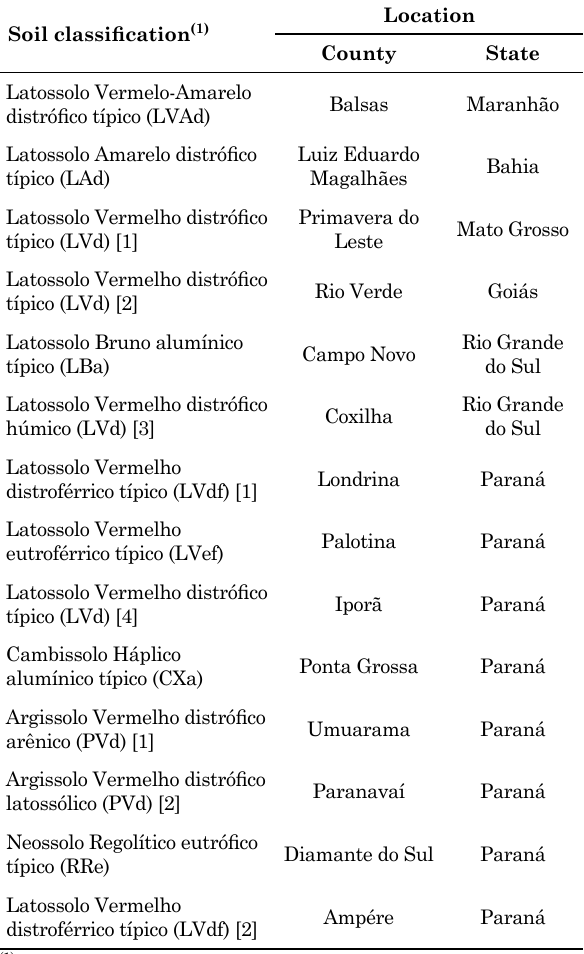
Table 1. Classification and location of soil samples from the 0-20 cm